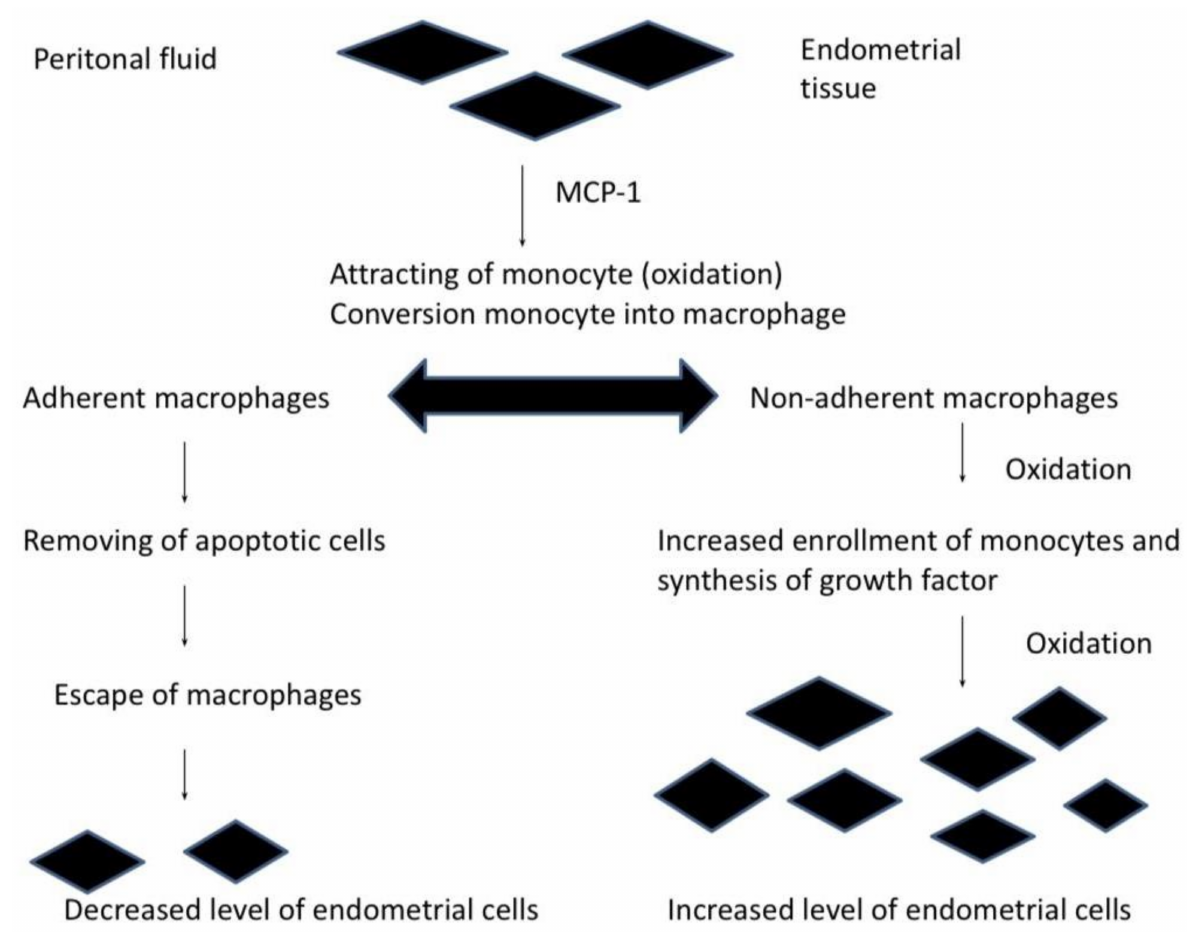
Figure 1. Oxidative stress in the mechanism of